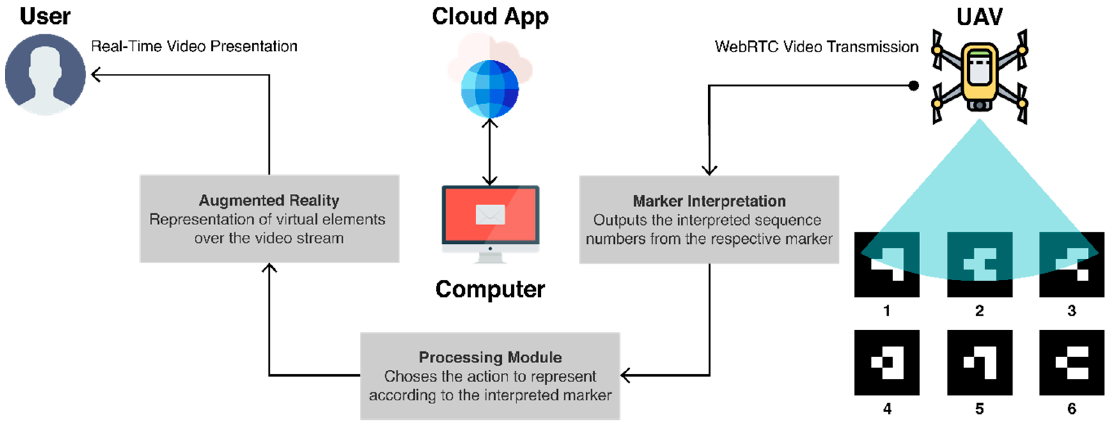
Figure 6. Architecture of the solution, which depends on three separate modules responsible for interpreting the visual markers, processing their meaning, and representing the AR experience.